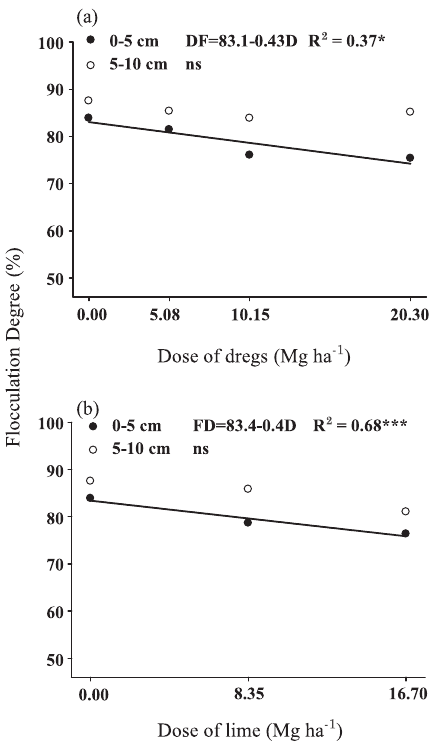
figure 5. flocculation degree (fd) in the layers of a humic cambisol amended with doses (d) of dregs (a) and lime (b) applied to the soil surface in 2004/2006. Bocaina do sul, sc, 2010. (*, **, *** and ns: significant at 5, 1, 0.1 % and not significant,